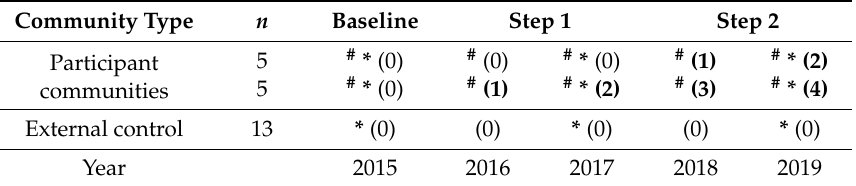
Table 1. Study design for the WHO STOPS cluster randomized controlled